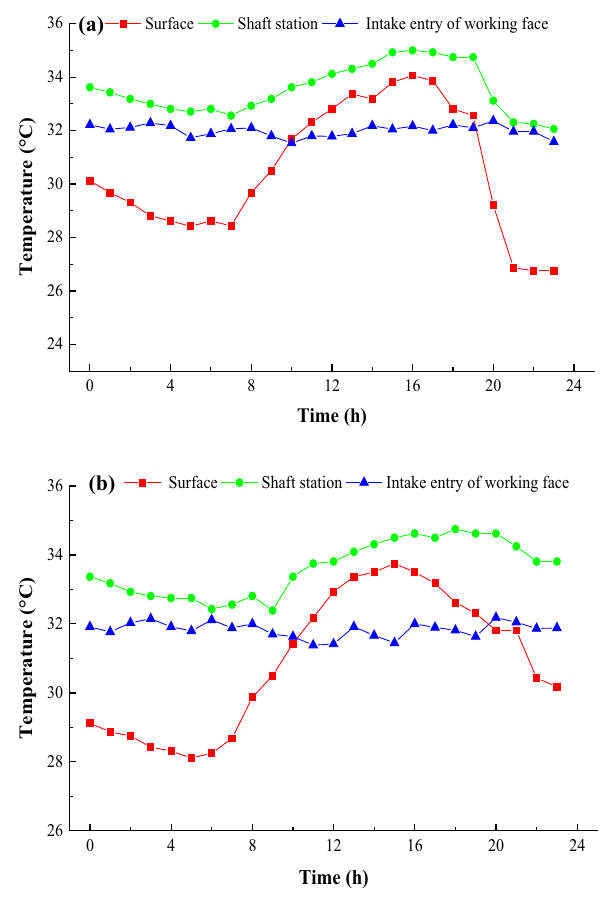
Fig. 5 Correlation between surface and underground temperatures recorded on a 02 August 2013 and b 03 August 2013